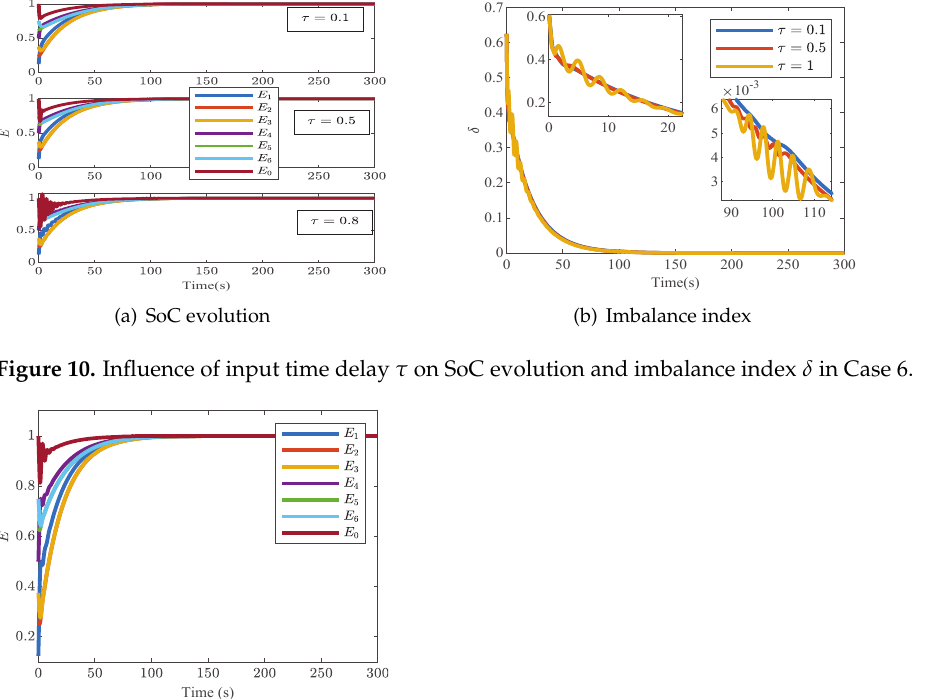
Figure 11. SoC evolution with τ = 0.8 and r = 0.2 in Case 6, and compared with SoC in Figure 10a, the amplitude of oscillation